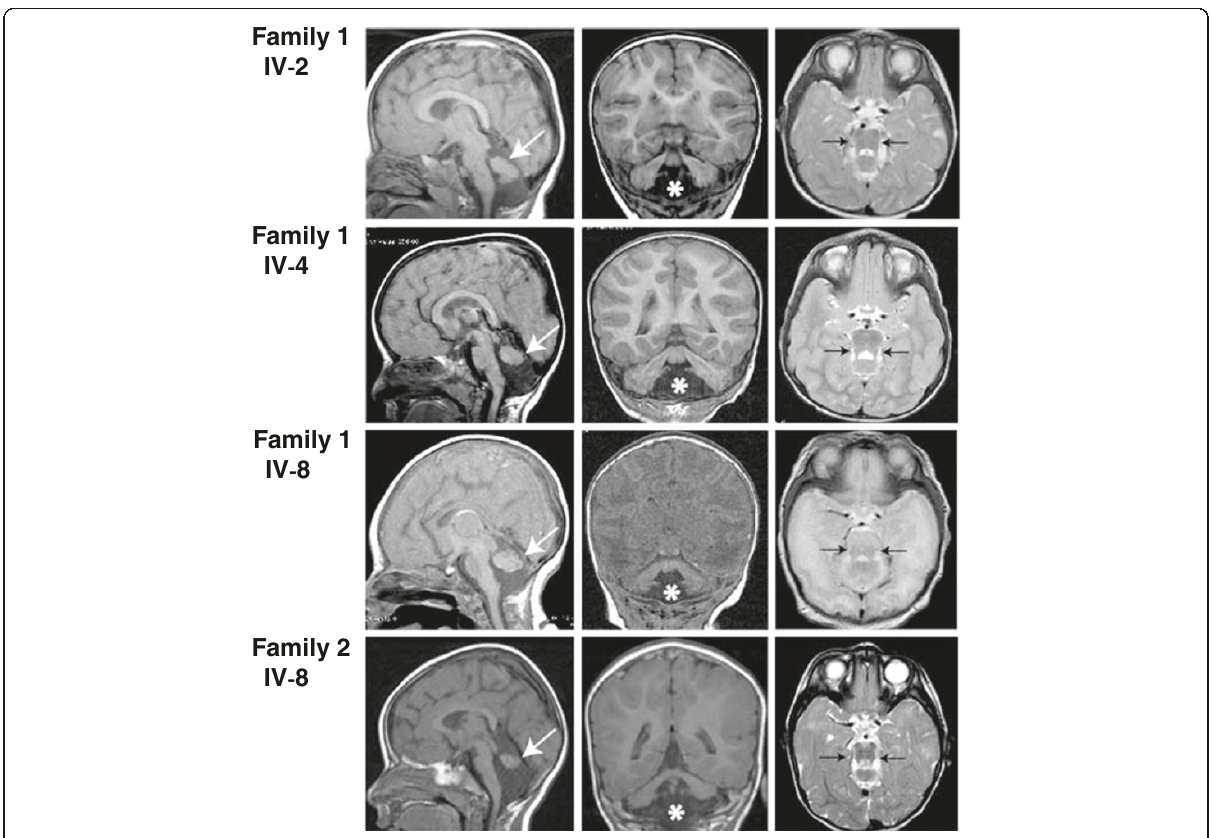
Figure 2 Brain MRI of affected individuals from Families 1 and 2. Left: midline parasaggital T1-weighted images showing absent inferior vermis, and hypoplastic inferior-cerebellum (arrows). Middle: coronal T1-weighted images showing neocortical pachygyria and mega cisterna magna (*). Right: Axial T2-weighted images showing typical square-shaped midbrain-hindbrain junction morphology in all patients